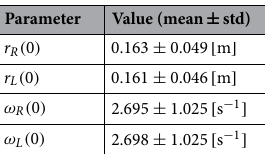
Table 2. The values of the model parameters estimated in the training